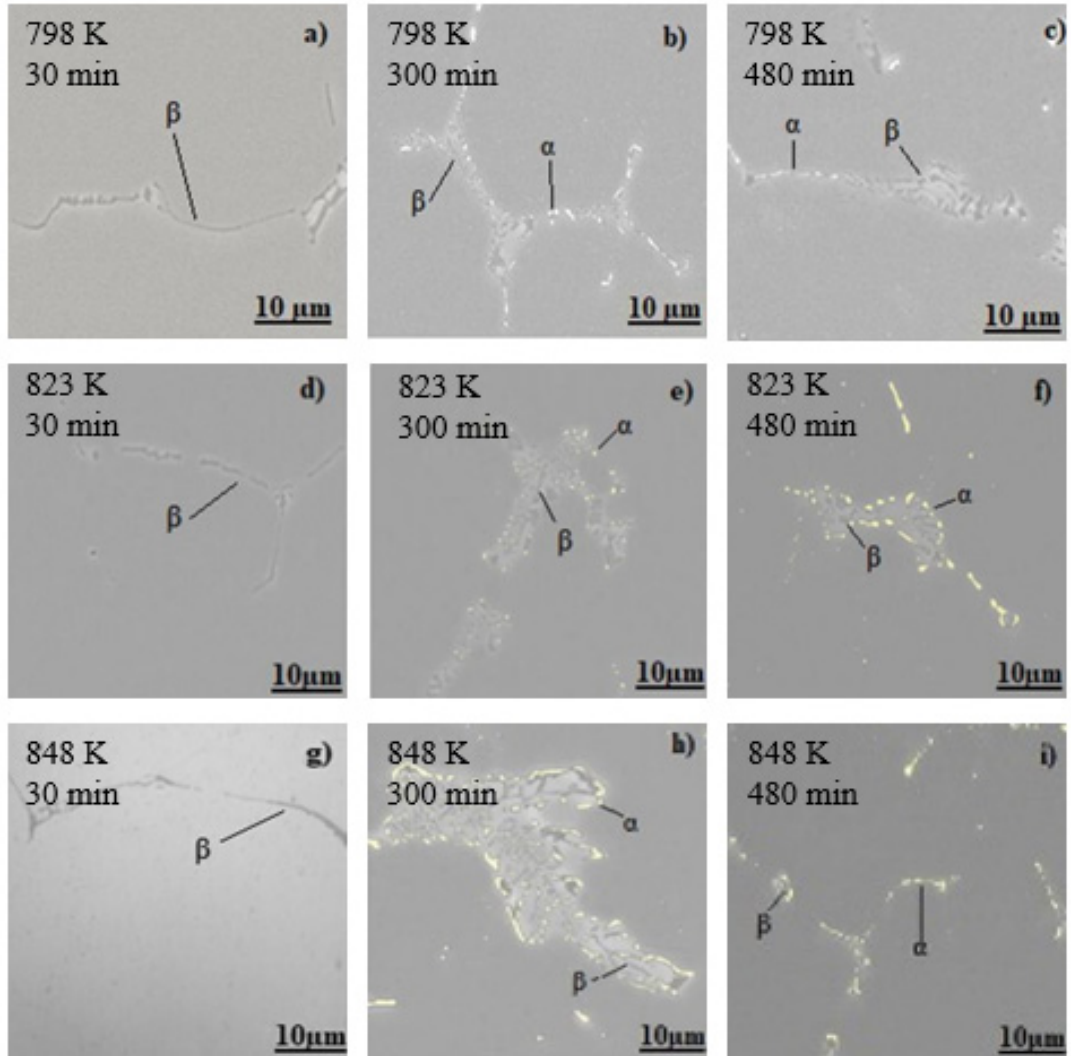
Figure 4. Micrographs of samples heat treated and attacked at the indicated temperatures (K) and times.